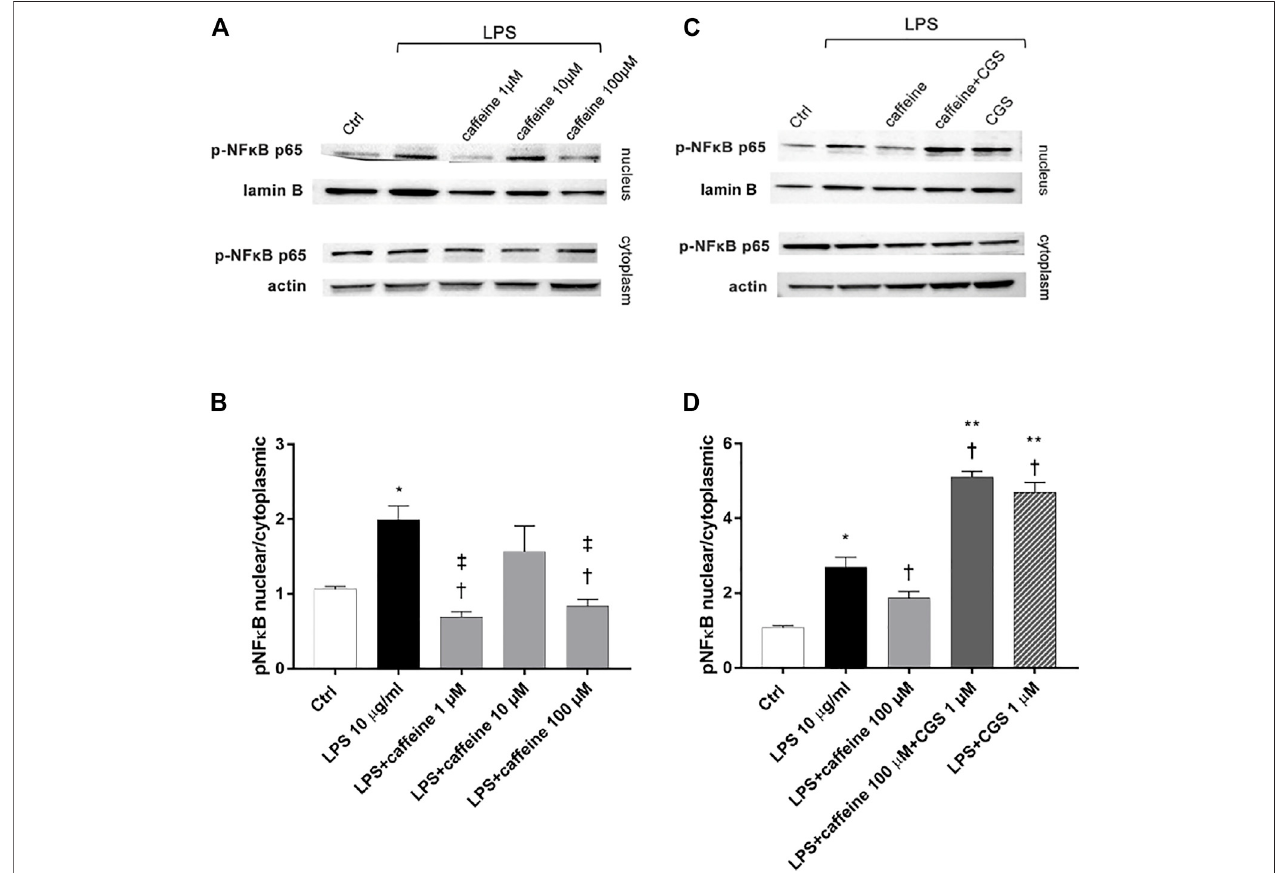
FIGURE 4 | Caffeine reduces nuclear translocation of p-NF κ B elicited by LPS. ARPE-19 were pretreated with caffeine (1 – 10 – 100 µM) and/or CGS (1 µM) for 24 h and then co-treated with LPS (10 μ g/ml) for 2 h (A – C) Representative blots of nuclear and cytoplasmic proteins (B – D) Densitometry of the p-NF κ B p65 nuclear translocation in treated cells (ratio of nuclear p-NF κ B p65/lamin B and cytoplasmic p-NF κ B p65/actin). Each bar represents the mean value ± SD; n (cid:1) 4. Data were analyzedbyone-wayANOVAandtheTukey posthoc testformultiplecomparisons.* p < 0.05 vs. control; † p < 0.05 vs. LPS10 μ g/ml; ‡ p < 0.05 vs. LPS+caffeine 10 μ M, ** p < 0.05 vs LPS + caffeine 100 µM.